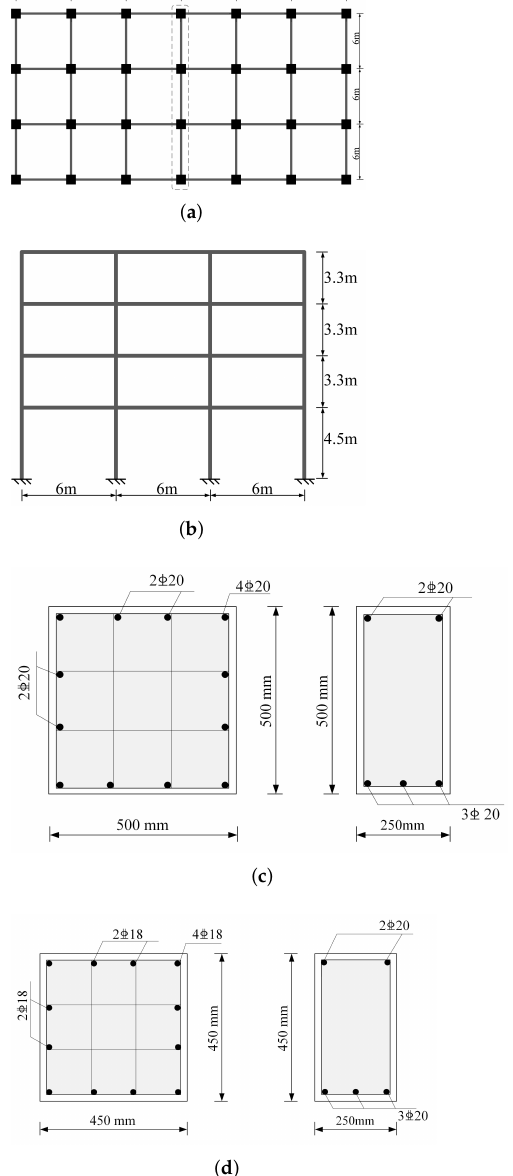
Figure 1. A four-storey RCMRF-framed office building: ( a ) plan view. ( b ) Elevation. ( c ) columns and beams for one floor. ( d ) columns and beams for floors